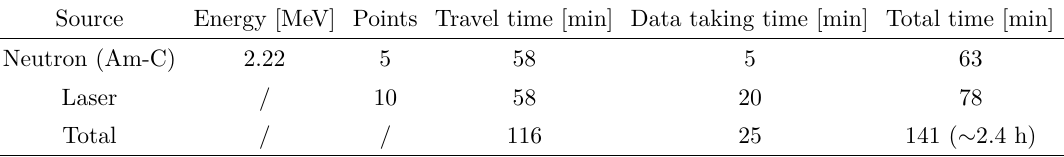
Table 6 . Weekly calibration using the